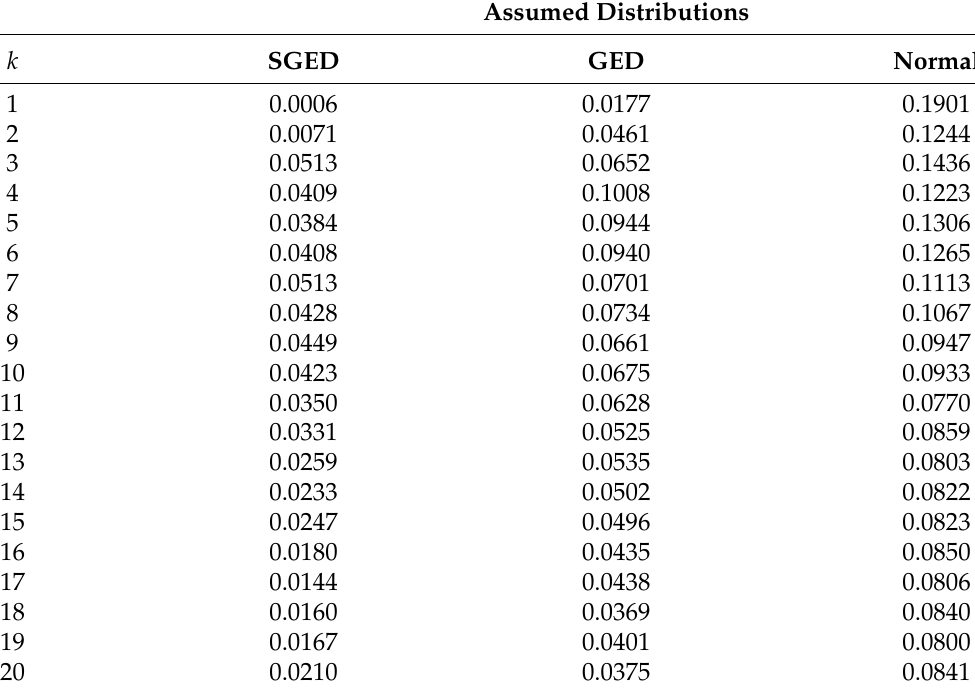
Table 4. Kullback–Leibler distance for empirical and fitted theoretical distributions of standard- ized residuals.